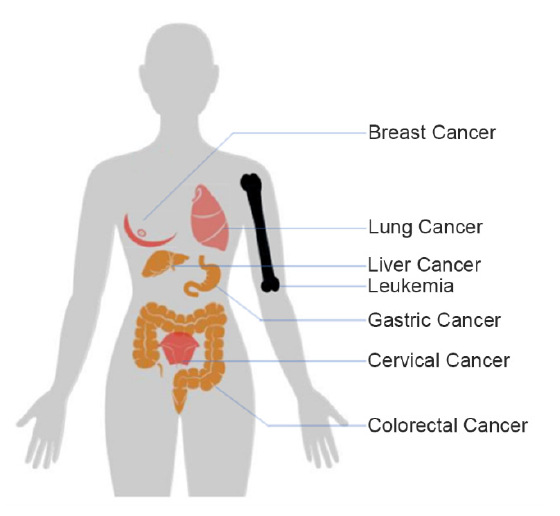
Figure 1. Distribution of different kinds of cancers in the human body. Figure was drawn according to reference [9] .